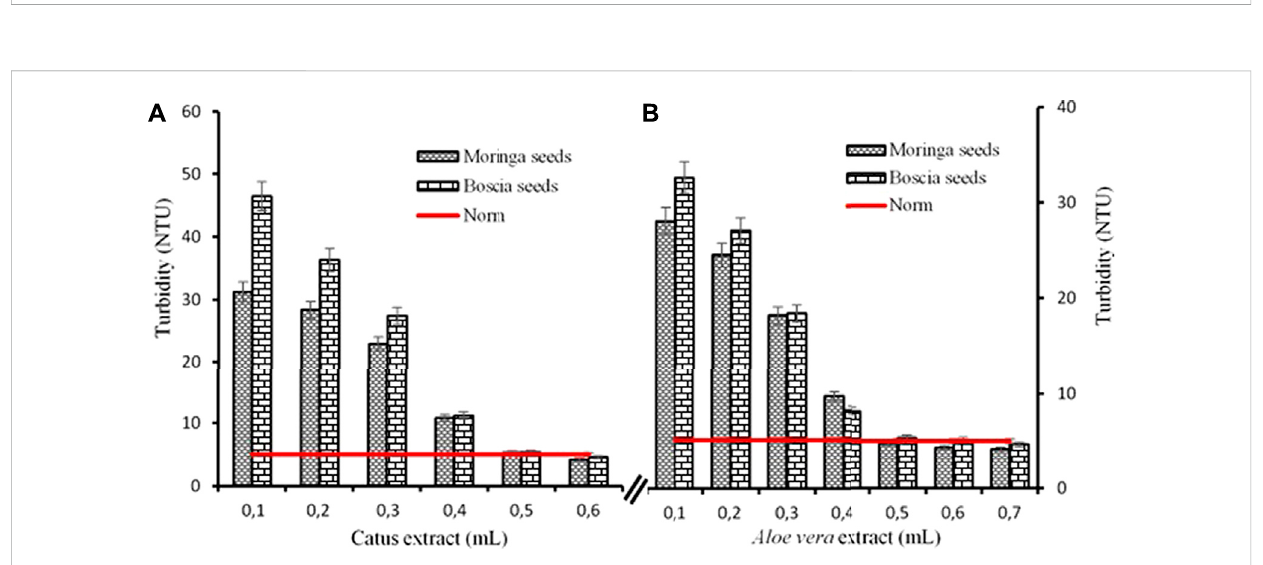
FIGURE 8 Evolution of turbidity of water samples as a function of the volume of cactus mucilage applied to the Moringa and Boscia seeds treatment (A) . Evolution of the turbidity of water samples as a function of the volume of Aloe vera mucilage applied to the treatment of Moringa and Boscia seeds (B)